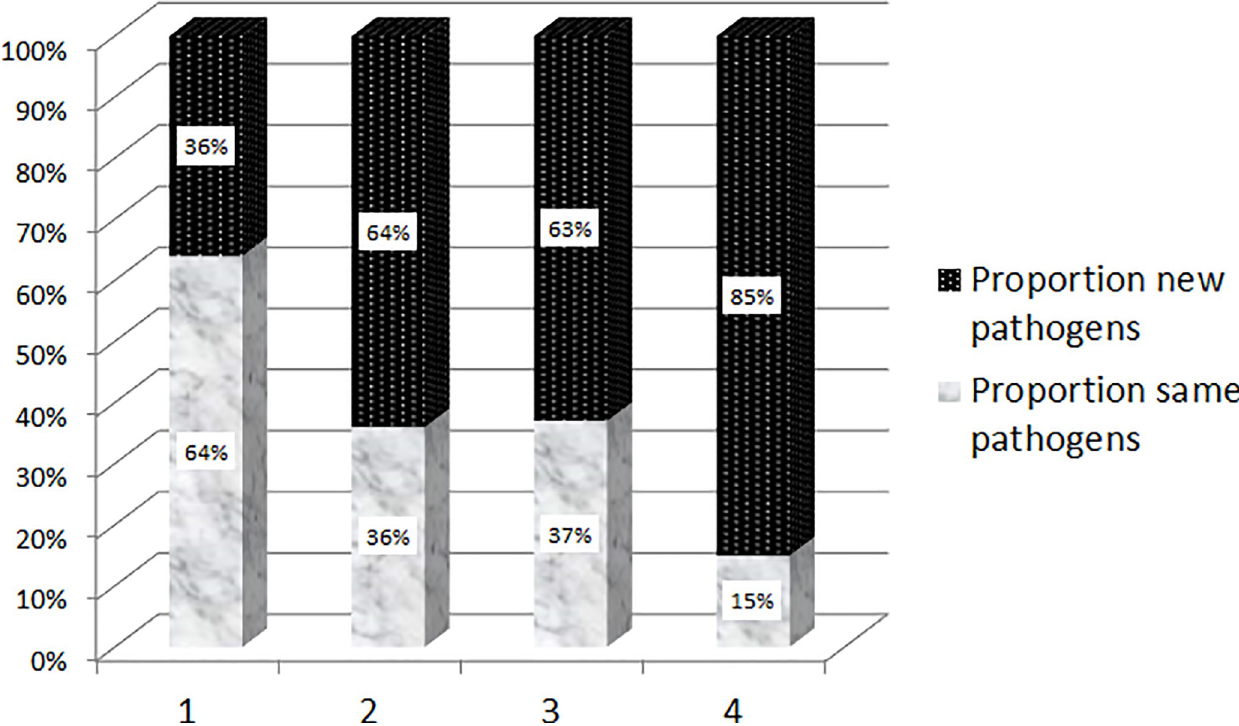
Fig 3. Proportions of known versus newly identified pathogens (vertical axis) stratified upon the number of debridement (horizontal axis).